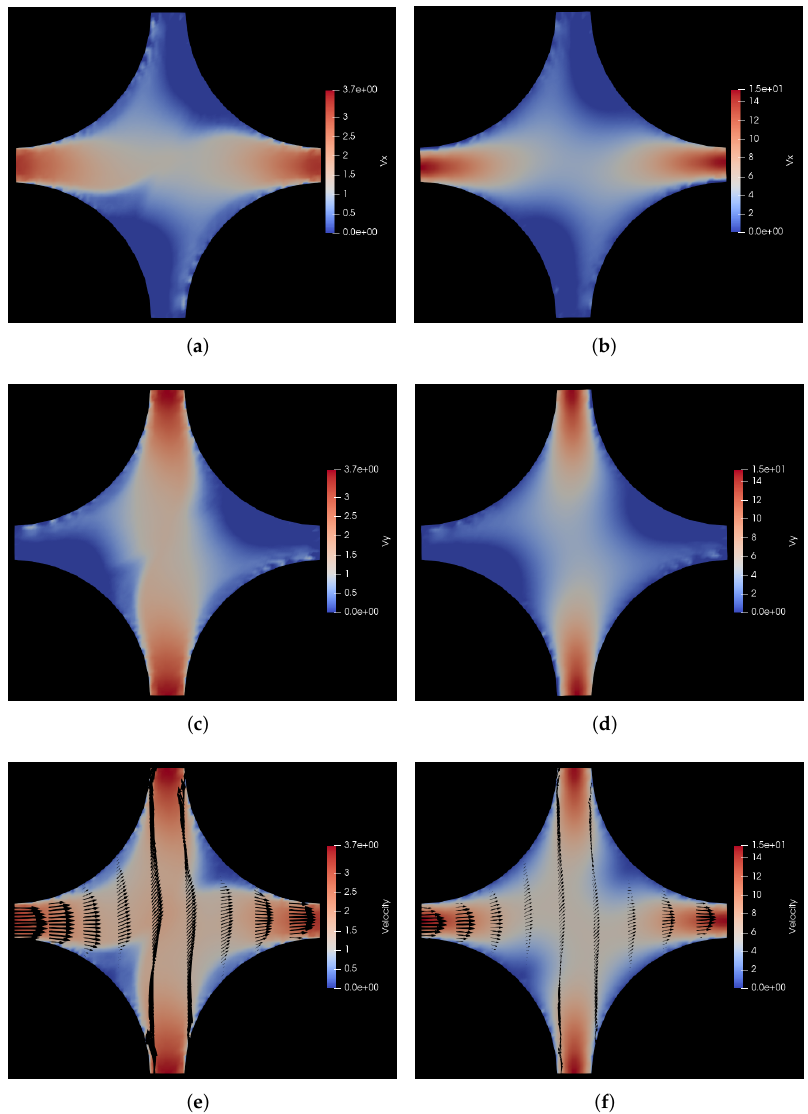
Figure 5. Comparison of velocity profiles for flow of polymer solution with the flow of solvent through a cylindrical porous medium with pressure applied along the positive x - y diagonal. ( a ) v x for flow of polymer solution. Here, v x varies from 0 to 3.7 σ /s, i.e., 0 to 18.5 µ m/s; ( b ) v x for flow of solvent. Here, v x varies from 0 to 15 σ /s, i.e., 0 to 75 µ m/s; ( c ) v y for flow of polymer solution. Here, v y varies from 0 to 3.7 σ /s, i.e., 0 to 18.5 µ m/s; ( d ) v y for flow of solvent. Here, v y varies from 0 to 15 σ /s, i.e., 0 to 75 µ m/s; ( e ) v for flow of polymer solution. Here, v varies from 0 to 3.7 σ /s, i.e., 0 to 18.5 µ m/s; ( f ) v for flow of solvent. Here, v varies from 0 to 15 σ /s, i.e., 0 to 75 µ